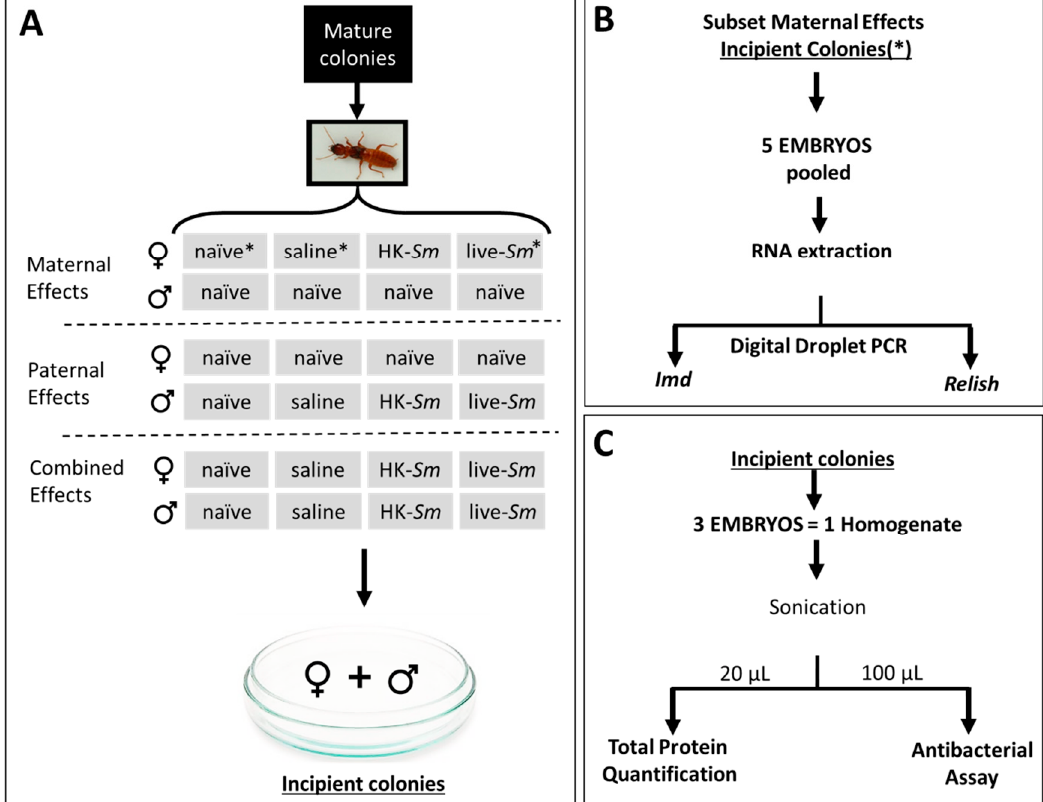
Figure 1. Experimental scheme and protocols. ( A ) Virgin alates were collected from mature colonies, de-winged, and weighed. Parental effects (either maternal, paternal, or combined maternal and paternal) following Serratia exposure were tested by treating de-winged reproductives with one of three injections—saline, heat-killed Serratia (HK- Sm ), or live Serratia (live- Sm )—or leaving the reproductives untreated (naïve). These individuals were then paired with mates to form incipient colonies. Pairs were set up in Petri dishes with 2.5 mg of white birch wood and dampened Whatman #1 filter paper. ( B ) In a subset of the maternally treated colonies (where naïve, saline, and Live- Sm queens were paired with naïve kings, indicated with the symbol * in A ), five embryos (two days old) per colony were pooled into a single sample and subsequently used in RNA extraction and Digital Droplet PCR to quantify two immune-related genes. ( C ) Following the onset of oviposition, two-day-old embryos resulting from all pairings in ( A ) were collected. Three embryos per incipient colony were pooled into a single homogenized sample. This pooled sample was divided in two aliquots, one to quantify protein content and the second to test that sample’s antibacterial properties. Sample sizes for A, B, and C are given in Table 1.